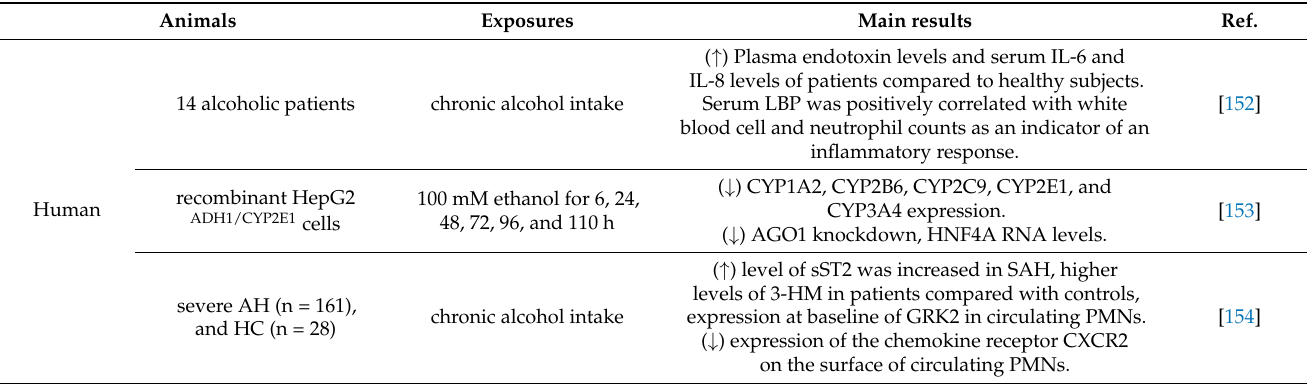
Table 2. Robust predictions of the recent genomic and metabolic properties in humans with ALD. Main